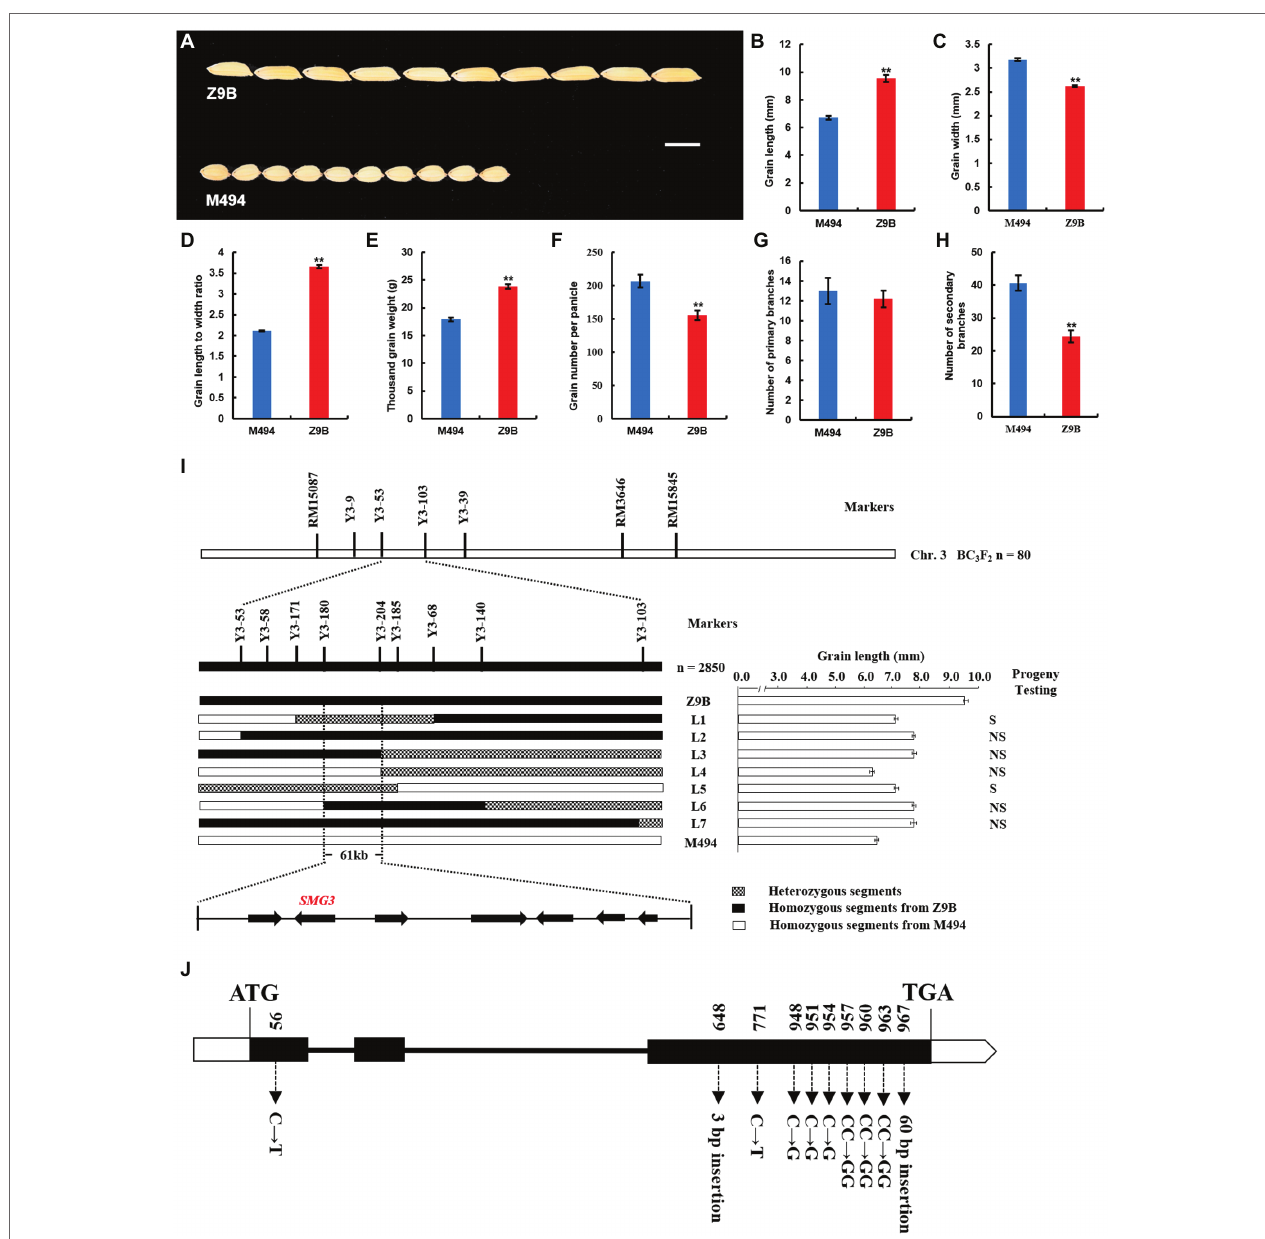
FIGURE 1 | Map-based cloning of SMG3 . (A) Z9B and M494 rice grains. Scale bar: 6 mm. (B–H) Comparison of Z9B and M494 grain length ( n = 20; B ), grain width ( n = 20; C ), grain length to width ratio ( n = 20; D ), thousand grain weight ( n = 20; E ), grain number per panicle ( n = 20; F ), number of primary branches ( n = 20; G ), and number of secondary branches ( n = 20; H ). Data are given as means ± SD. **indicates p < 0.01 by Student’s t -test. (I) Fine mapping of SMG3 and candidate gene analysis. S, segregation; NS, no segregation. (J) Gene structure and allelic variations of LOC_Os03g29614 ( SMG3 ) between Z9B and M494. Filled boxes represent exons, black lines represent introns. The start codon (ATG) and the stop codon (TGA) are